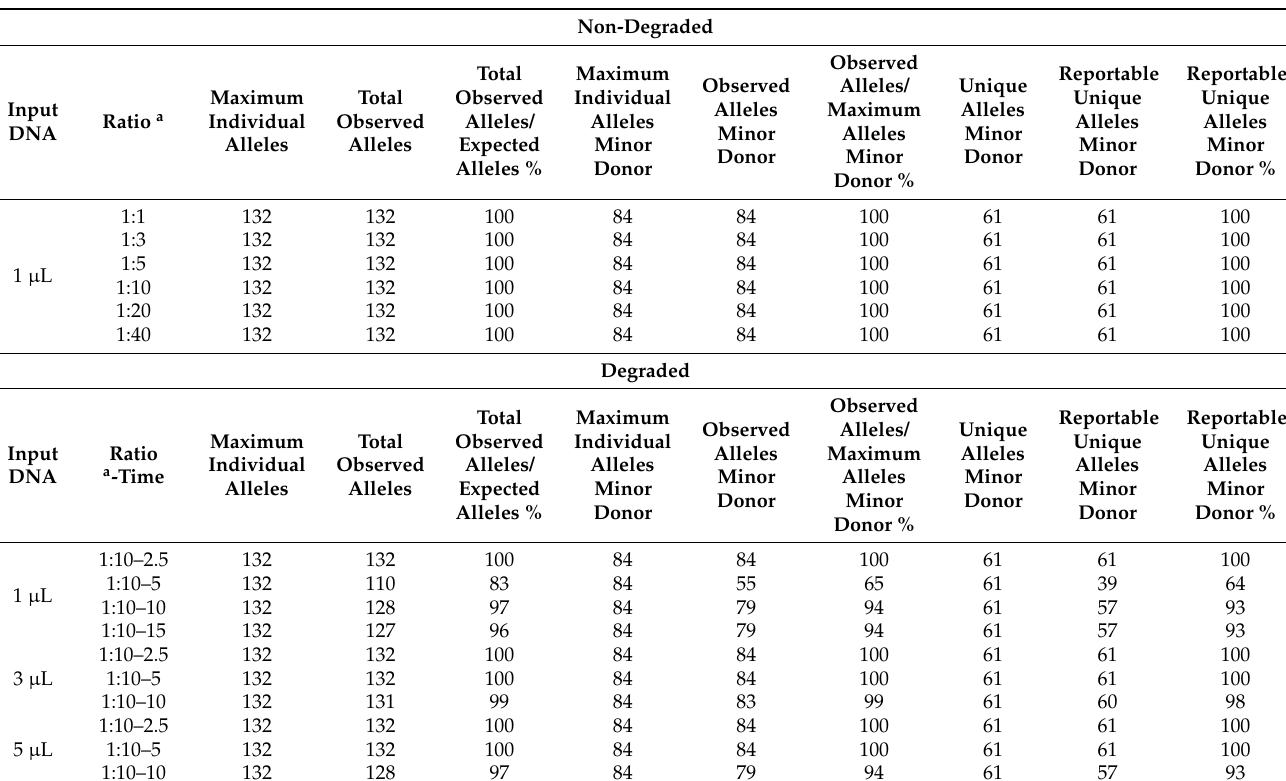
Figure 6. Scatter plot of 50 MHs for the number of alleles, heterozygosity (Het) and A e . Relationship among the number of alleles, Het, and A e values. Table 2. Summary results of MPS-MHs of two-person